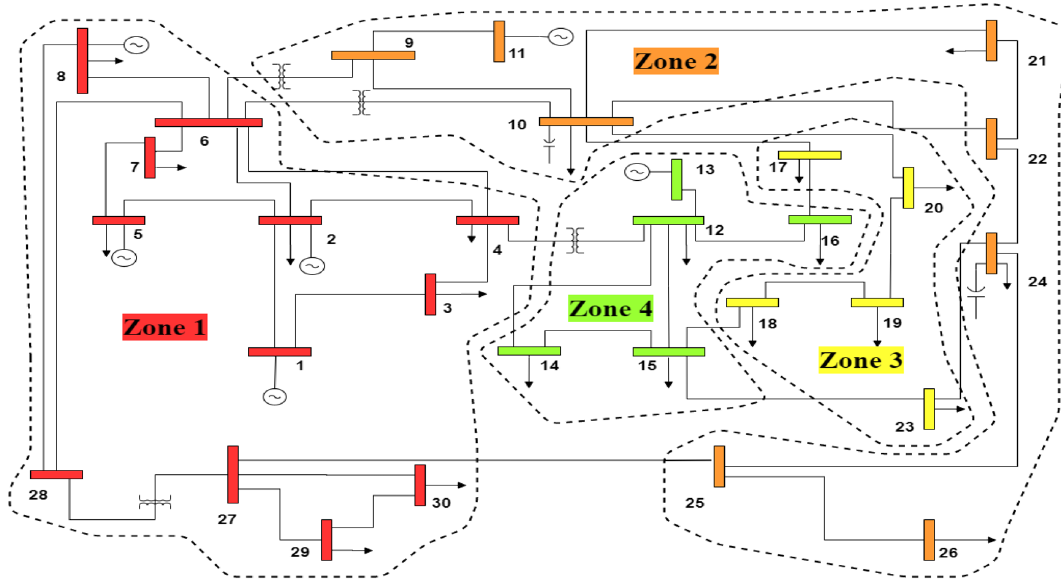
Fig. 1 Clusters/Zones for congested line 1–2